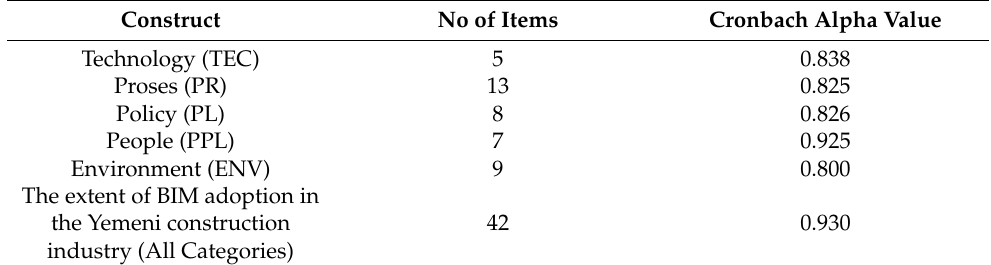
Table 4. Cronbach Alpha (Pilot Study) Constant factors affecting BIM adoption.